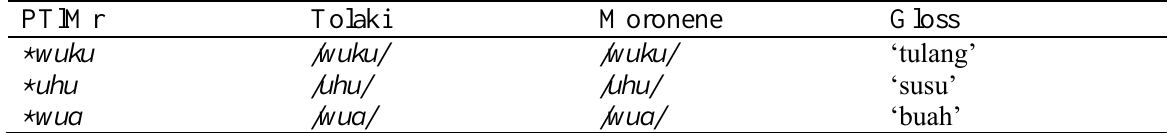
Table 9. The middle position of the word